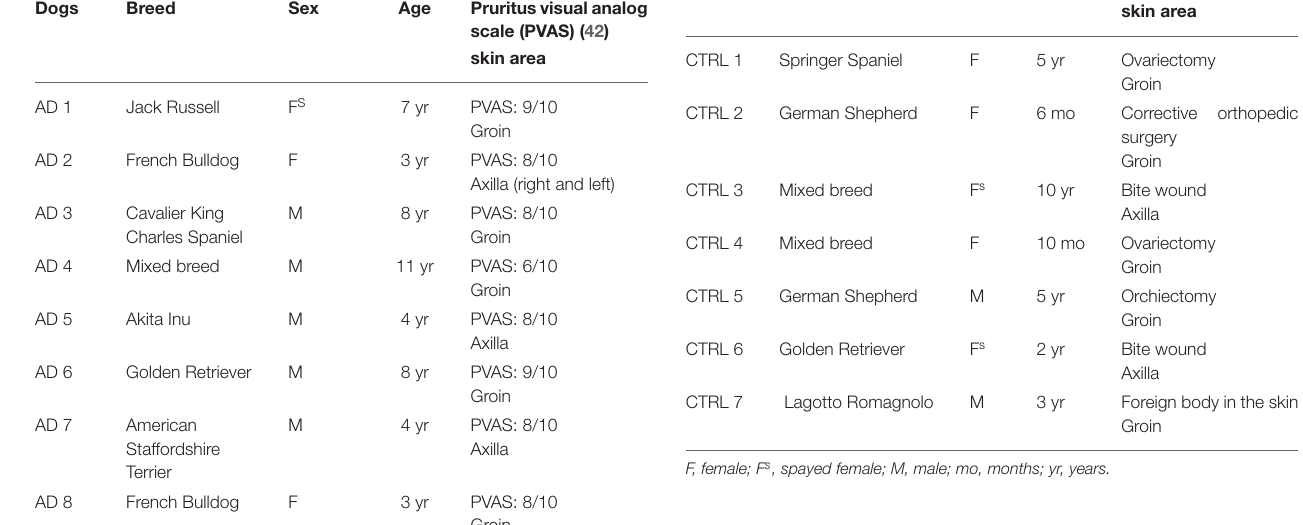
TABLE 1 | Clinical data of the dogs with atopic dermatitis (AD) enrolled in the present study. Dogs Breed